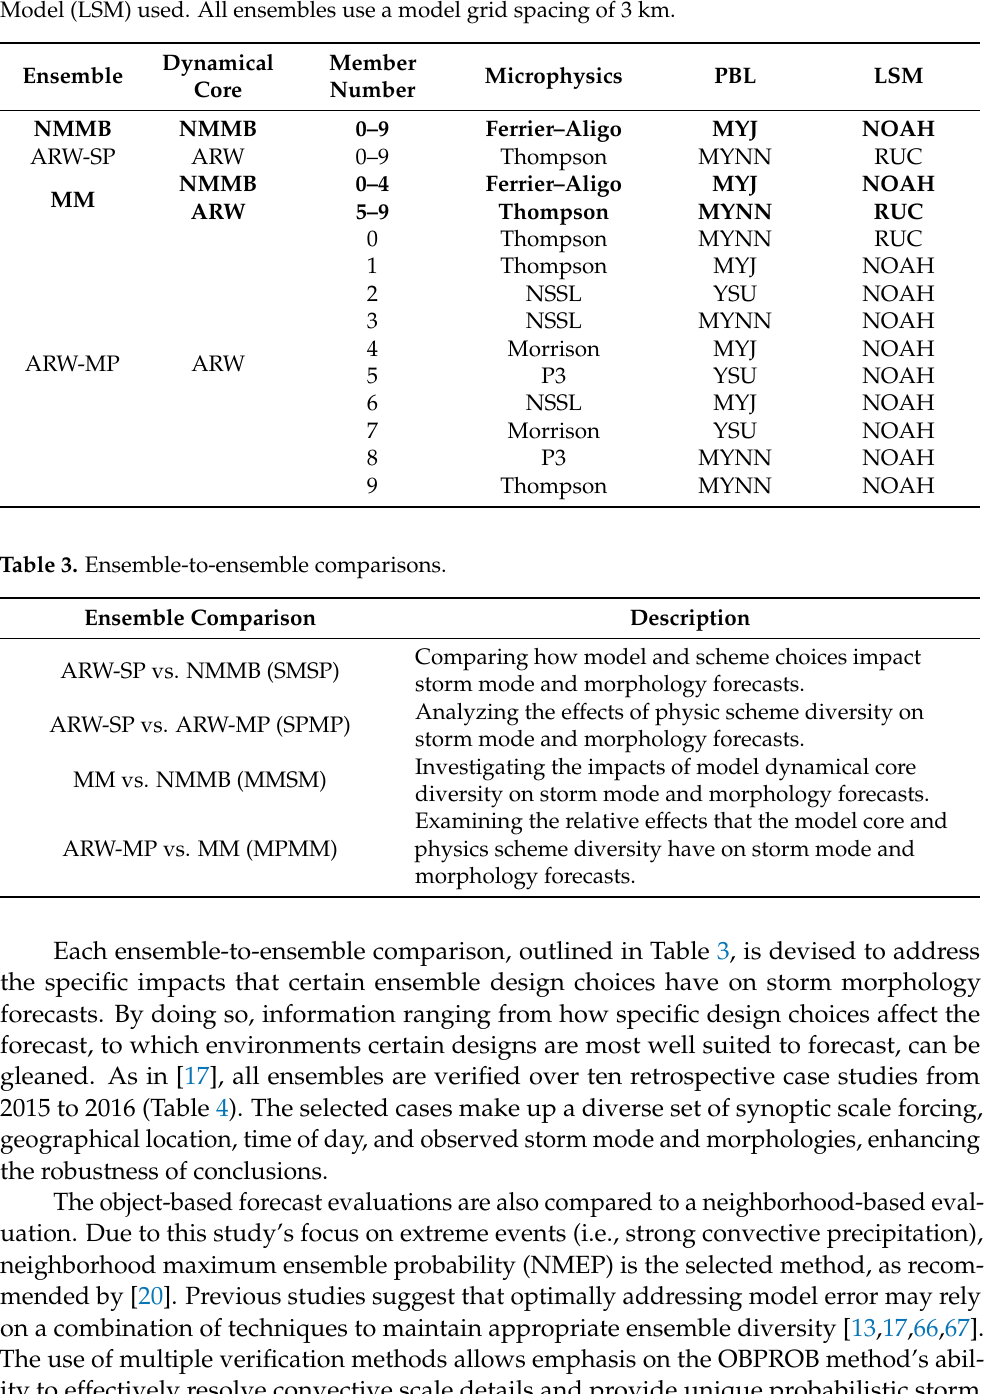
Table 2. Ensembles and their design. The first column shows the name of the ensemble configuration. The second column shows the WRF dynamical core(s) used for that ensemble. The third column shows the member numbers used to identify ensemble members with particular configuration details. The fourth column shows the microphysics parameterization scheme used, the fifth column shows the Planetary Boundary Layer Scheme (PBL) used, and the sixth column shows the Land Surface Model (LSM) used. All ensembles use a model grid spacing of 3 km. Ensemble